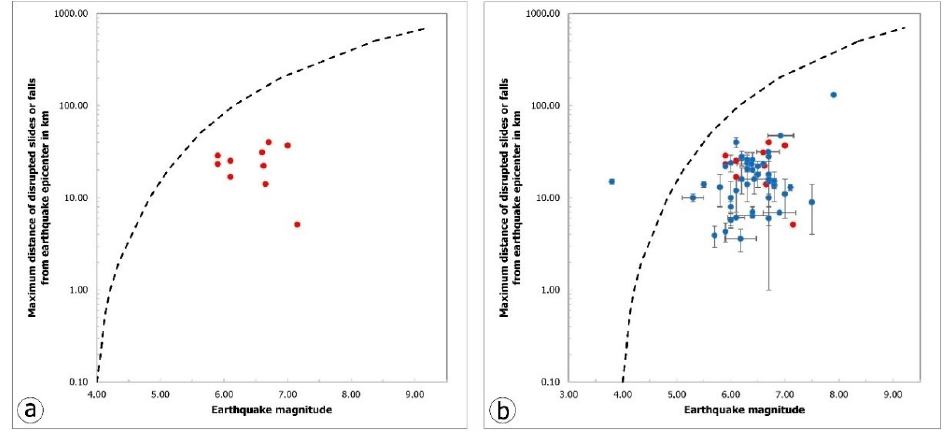
Figure 6. ( a ) Maximum distance from earthquake epicenter of disrupted slides and falls induced by historical and recent earthquakes of different magnitudes generated onshore and offshore Cephalonia versus earthquake magnitude. The dashed line is the upper bound for disrupted slides or falls by Keefer [7]. ( b ) Maximum epicentral distances of landslides triggered by historical and recent earthquakes of different magnitudes versus earthquake magnitude. The red subset comprises data from Cephalonia and the blue subset from around Greece published by Papadopoulos and Plessa [17]. The dashed line is the upper bound for disrupted slides or falls by Keefer [7].